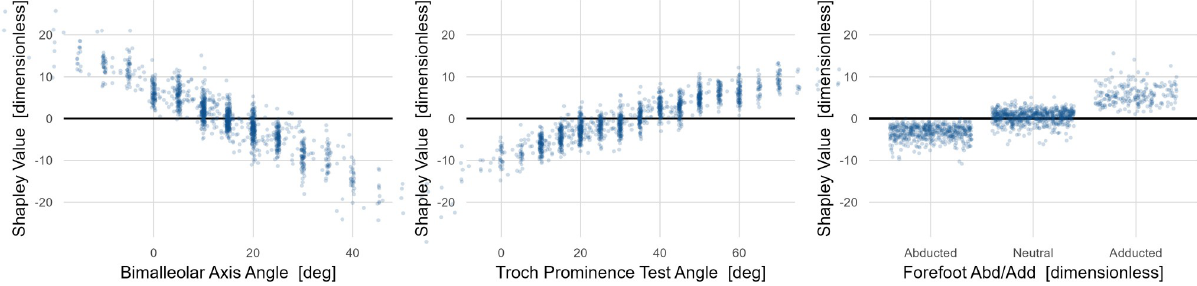
Fig 3. Dependence plots for Structure and Function variables with large effects on mean stance foot progression. The three most important causal variables are shown. The effects of long bone torsions (femur and tibia) are nearly linear. Note that for many years measurements were only recorded at five-degree increments, leading to vertical striations in the left and middle panels.